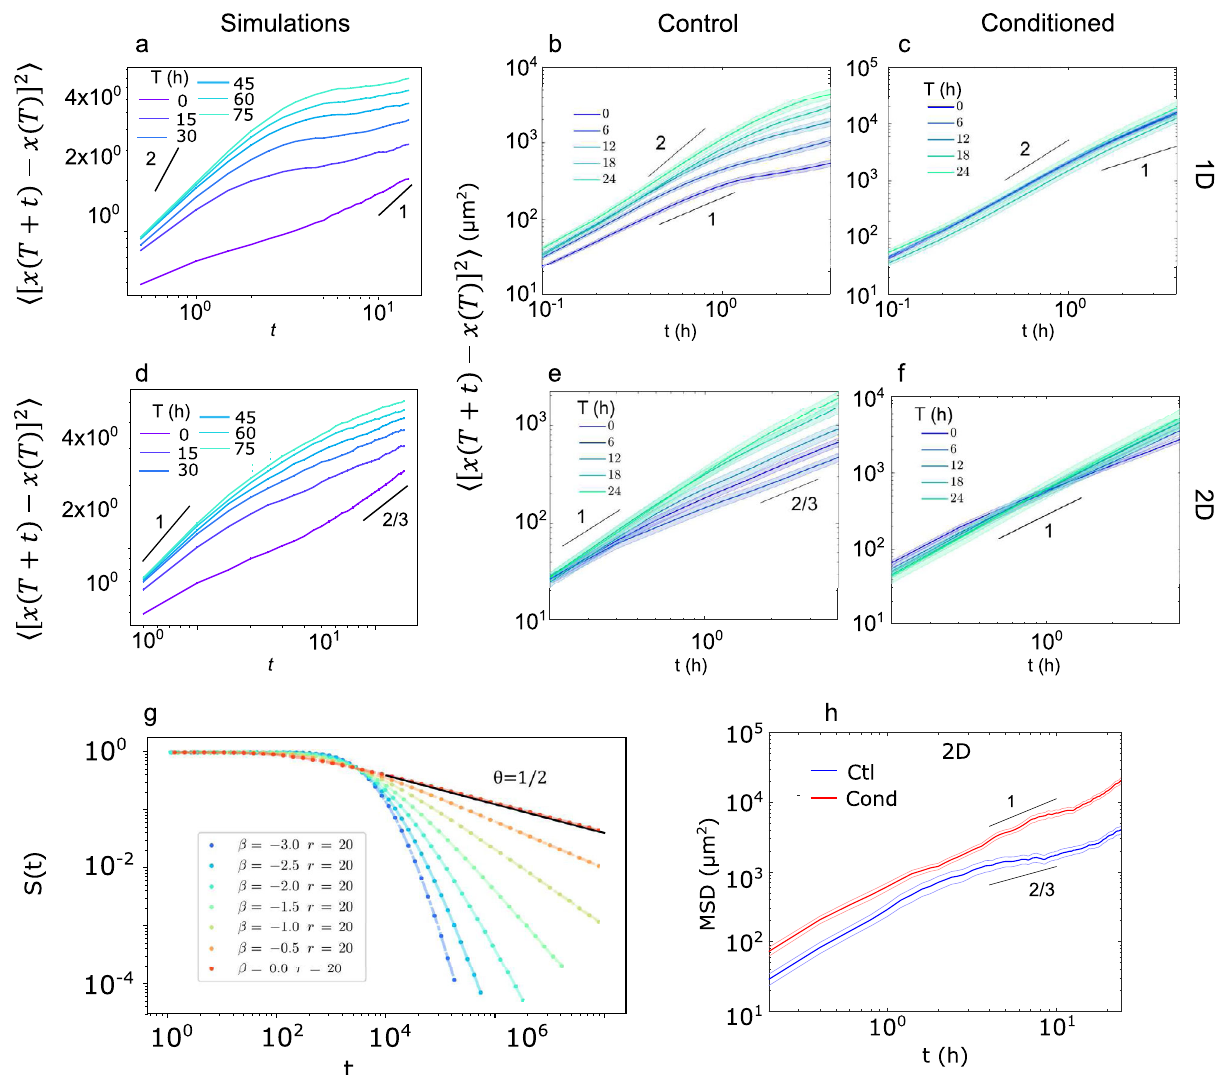
Fig. 4 The PSATW model predicts altered cell trajectory statistics and a better exploration of space in both 1D and 2D. a – f Increments of the mean square displacements in 1D ( a – c ) or 2D ( d – f ) settings. Data from simulations ( a , d ) and experiments on control ( b , e ) and conditioned ( c , f ) substrates. Lines are guides for the eye showing the various exponents predicted by the theory. In panel a cell to cell variability and fl uctuations of cell speed were taken into account as discussed in SI. In panels b , c , e , and f the error bars show the S.E.M. for n > 100 trajectories from 3 (1D) and 2 (2D) independent experiments. g Survival probability S ( t ) of a target located at a distance r of the origin in 1D as a function of time. The long-time scaling exponent, θ , decreases as e (cid:2) β . h Mean square displacement of isolated cells moving on 2D surfaces in logarithmic scale. Control (Ctl, blue) and conditioned (Cond., red) 2 substrates. The error bars show the S.E.M. for n = 203 and 172 trajectories from two independent experiments for control and conditioned substrates,